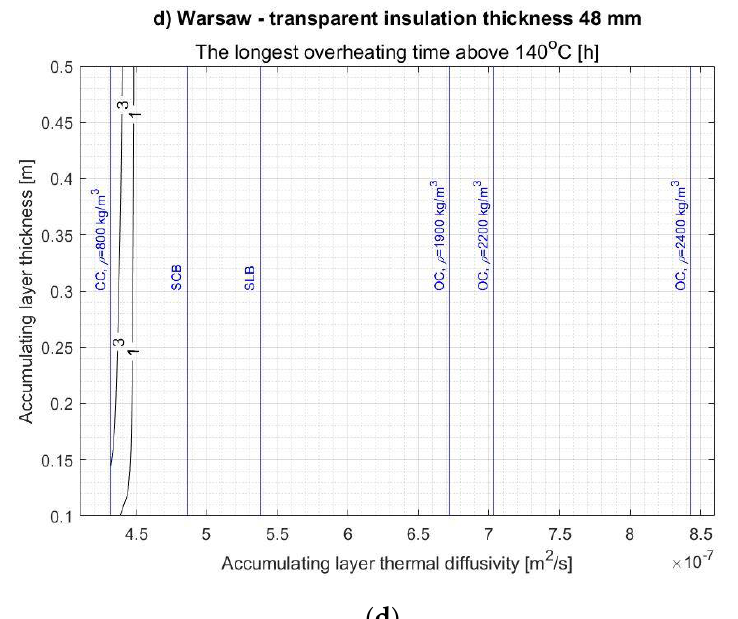
Figure A4. Contour graphs characterizing the SW basic parameters in a function of AL thermal diffusivity and thickness for the whole heating season: ( a ) the heat balance of the SW’s unit area, ( b ) the heating time, ( c ) the mean time lag of the maximum temperature on the absorber and SW’s internal surface during the day, ( d ) the longest overheating time above 140 °C in the TI. TI thickness: 48 mm. Location: Warsaw.